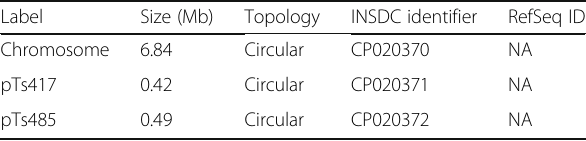
Table 3 Summary of genome of “ T. syntrophicum ” sp. nov. strain Cad16 T : one circular chromosome and two circular plasmids Label